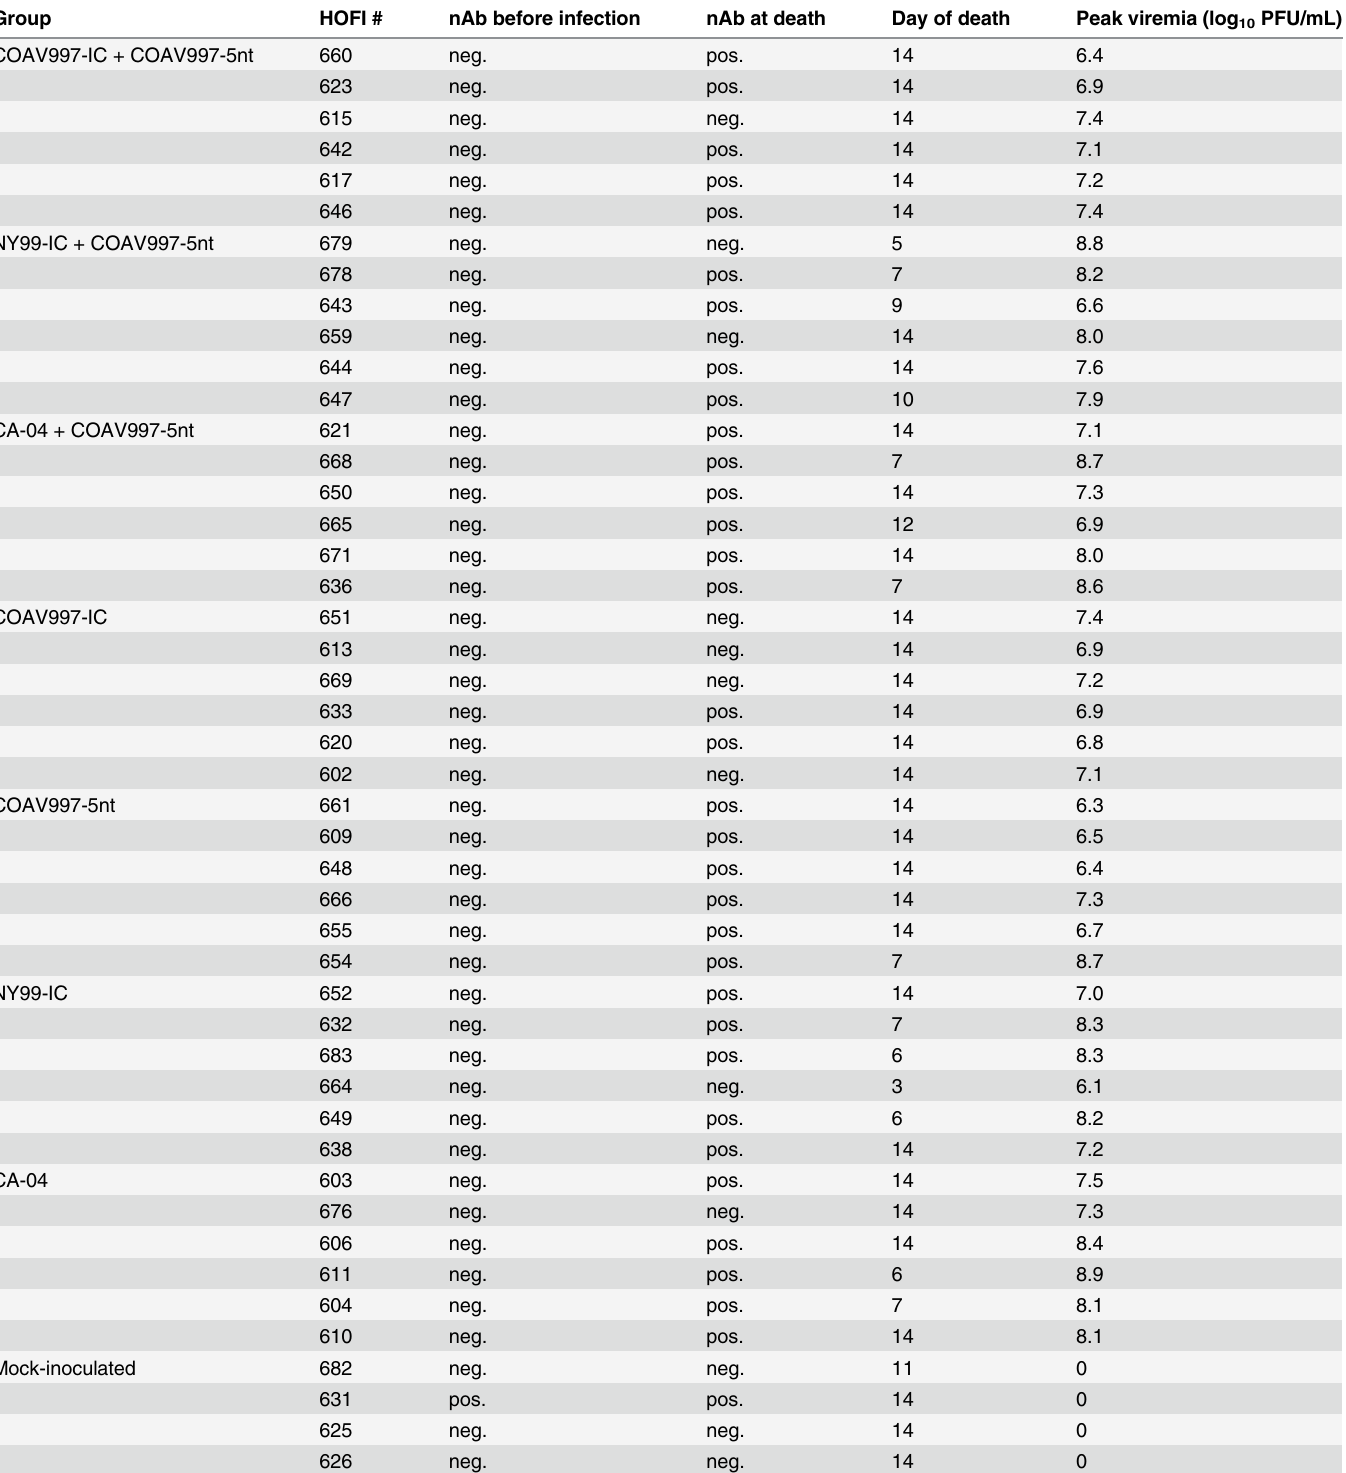
Table 3. Peak viremia and presence of neutralizing anti-WNV antibodies (nAb) in sera of HOFIs before infection and on day of death. Group HOFI # nAb before infection nAb at death Day of death Peak viremia (log 10 PFU/mL) COAV997-IC + COAV997-5nt 660 neg. pos. 623 neg. pos. 615 neg. neg. 642 neg. pos. neg. pos. neg. neg.